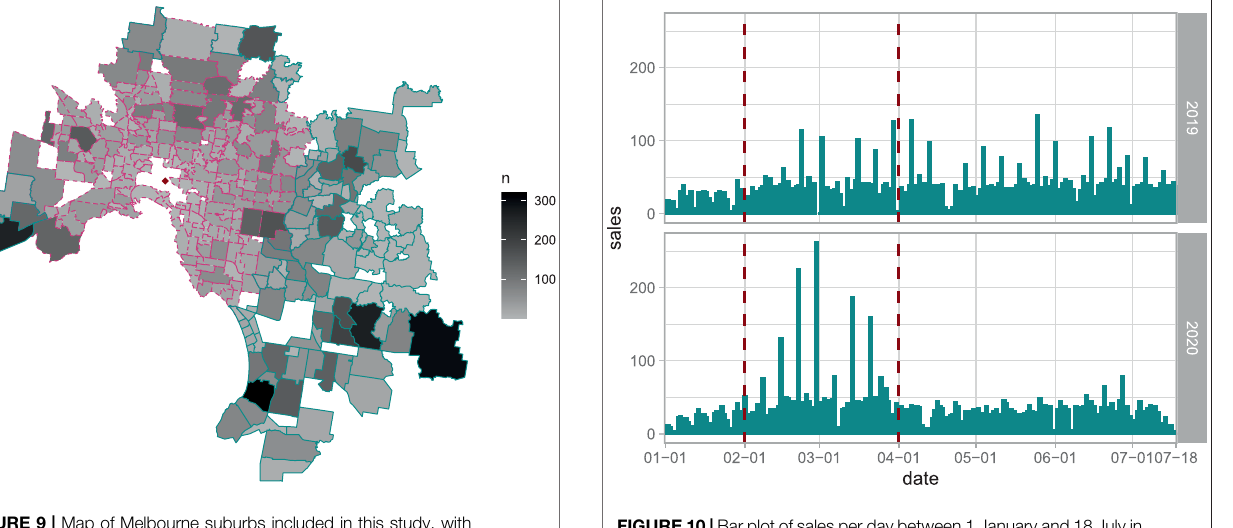
FIGURE 10 | Bar plot of sales per day between 1 January and 18 July in 2019 and 2020. Vertical dashed red lines indicate 1 February and 1 April, between which a spike in sales is observed.